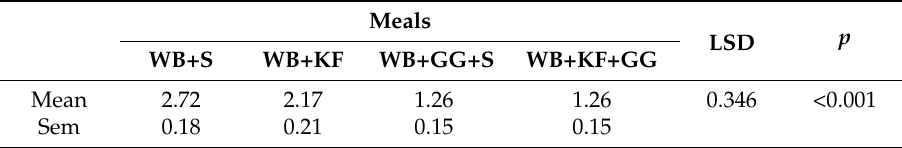
Table 3. Peak incremental blood glucose concentrations (mmol L − 1 ) in response to consuming meals containing wheat biscuit (WB), kiwifruit (KF) and guar gum (GG). Meals LSD p WB+S WB+KF WB+GG+S WB+KF+GG Mean 2.72 2.17 1.26 1.26 0.346 <0.001 Sem 0.18 0.21 0.15 0.15 Sem: Means and standard error of